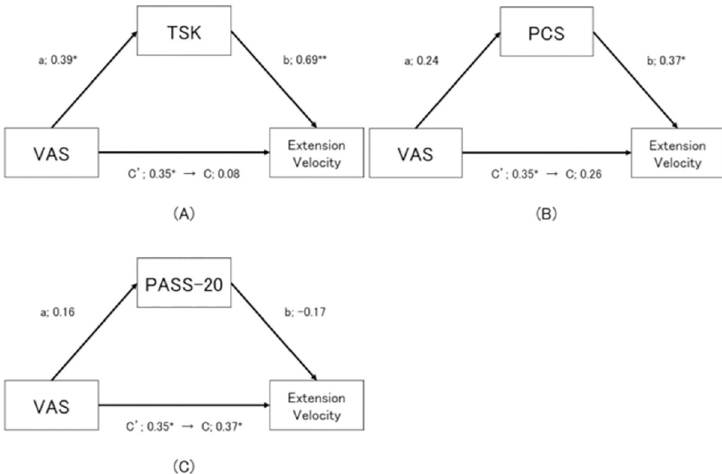
Fig 5. Psychological factors that mediated the relationship between the participants’ VAS scores for pain in the past 4 weeks and the peak trunk extension velocity. These images were created using the data from Trial 1. A: The TSK is the mediated variable. B: The PCS is the mediated variable. C: The PASS-20 is the mediated variable. � p < 0.05, �� p <